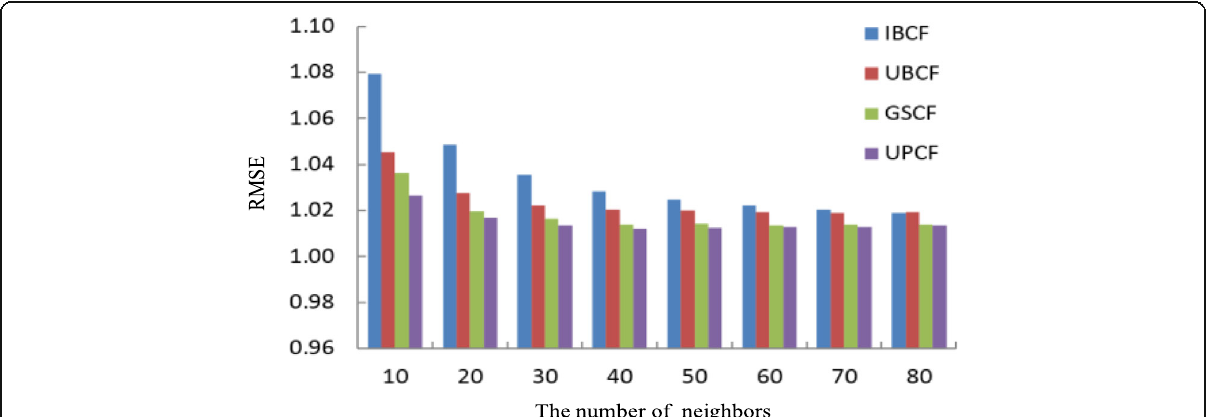
Fig. 5 The comparison of RMSE values between four algorithms in data set of train1. The RMSE value of the algorithm UPCF is always smaller than the other three recommendation algorithms (under the same number of neighbors). As the number of neighbors increases, the RMSE value becomes smaller first and then bigger. When the number of neighbors is about 40, the value of RMSE tends to be the smallest, that is, the error of the prediction score is the